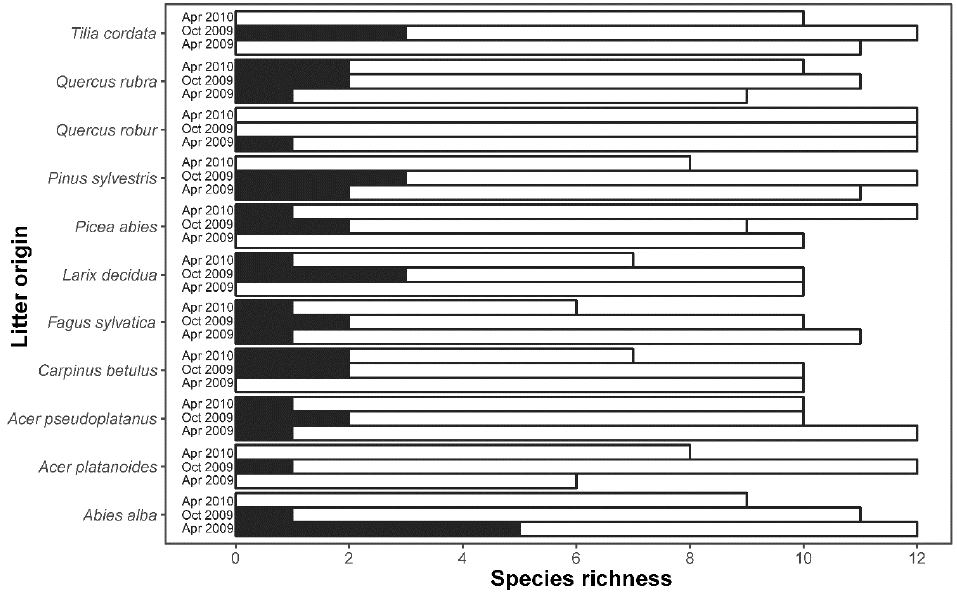
Figure 4. The richness of species noted in the control (during experiment setup—white) and not noted (colonizers—black) in mite communities studied.